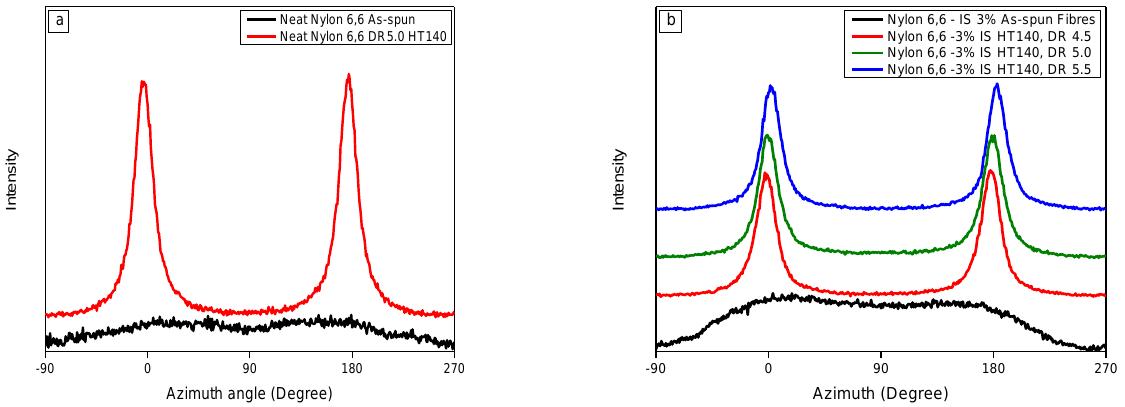
Figure 6. Azimuthal angle of as-spun and drawn neat ( a ) and salt-confined ( b ) nylon 6,6 fibres at different drawing ratio at drawing temperature of 140 °C.